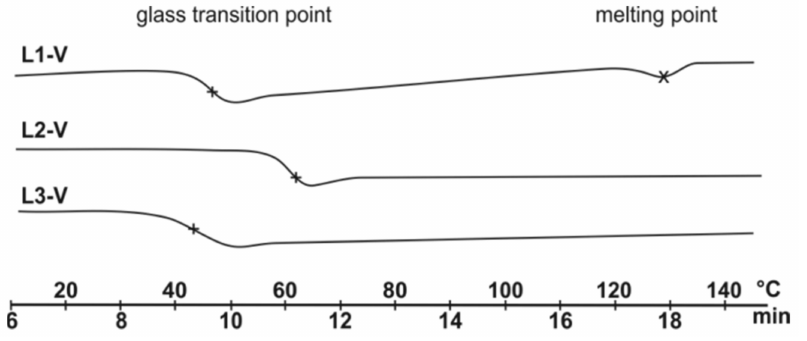
Figure 2. DSC thermograms of selected copolymer samples obtained using the studied catalysts (Table 1, items 4, 8, 12, Figures S24, S28 and